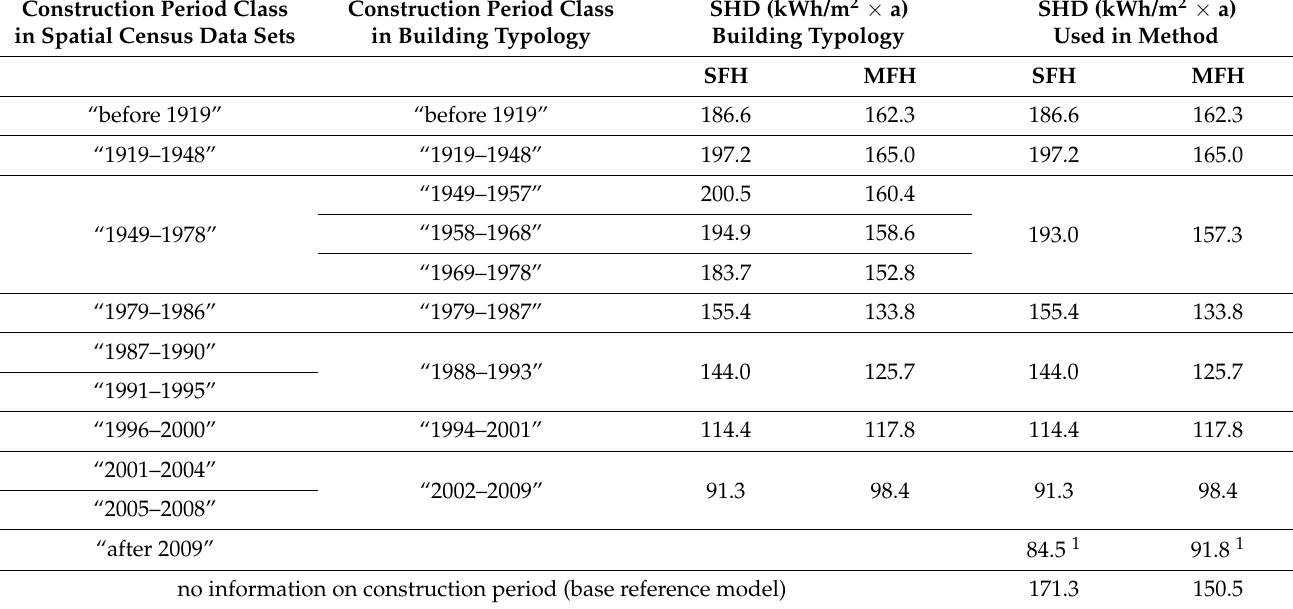
Table 1. Construction period classes used in the two spatial census data sets against classes of the regional building typology as well as corresponding standard heat demand (SHD) values for single- and multi-family houses (SFH and MFH) and values used in the presented